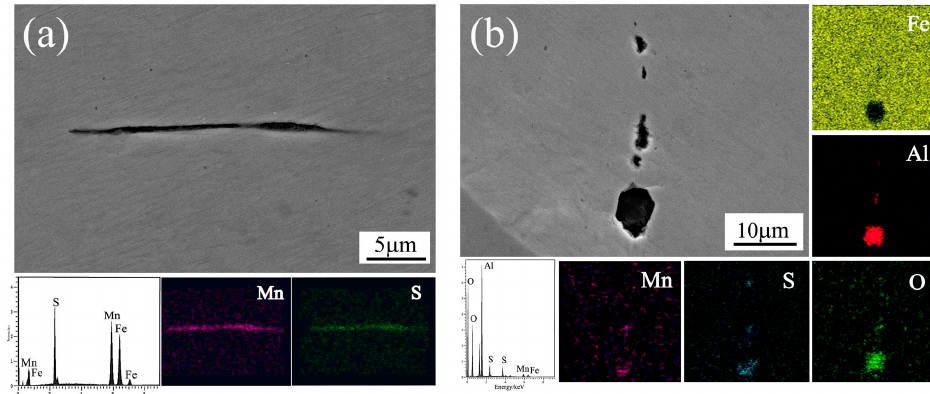
Figure 10. SEM images and EDS mapping of inclusions in ( a ) Q235B and ( b ) Q355B.